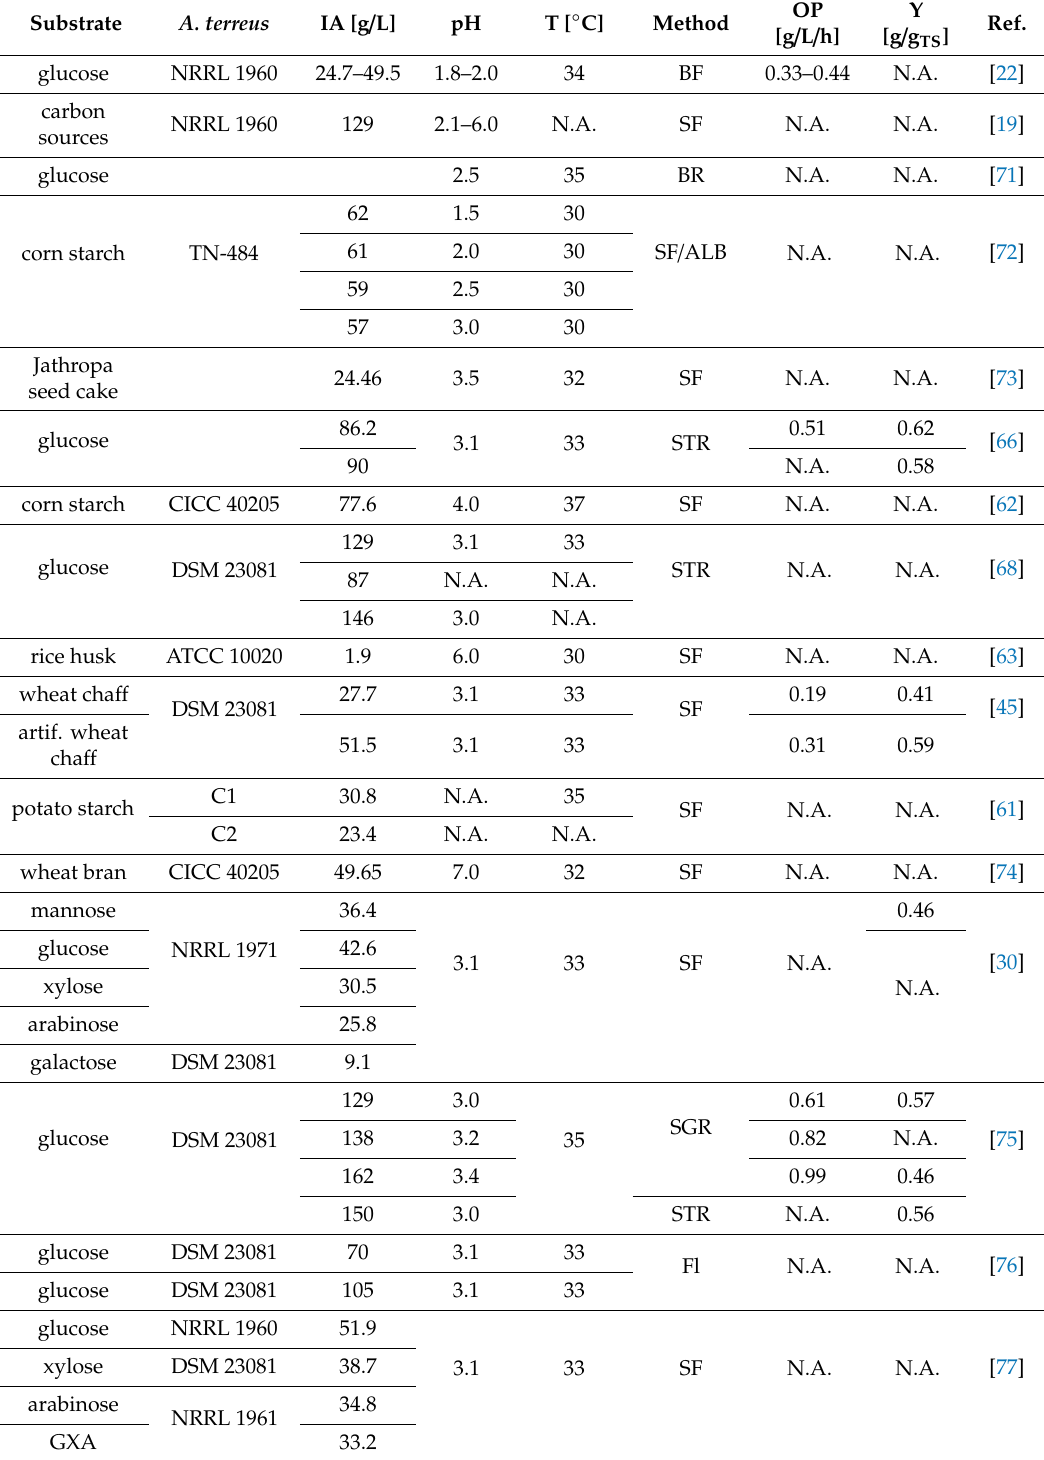
Table 1. Fermentation parameters and yields using di ff erent A. terreus